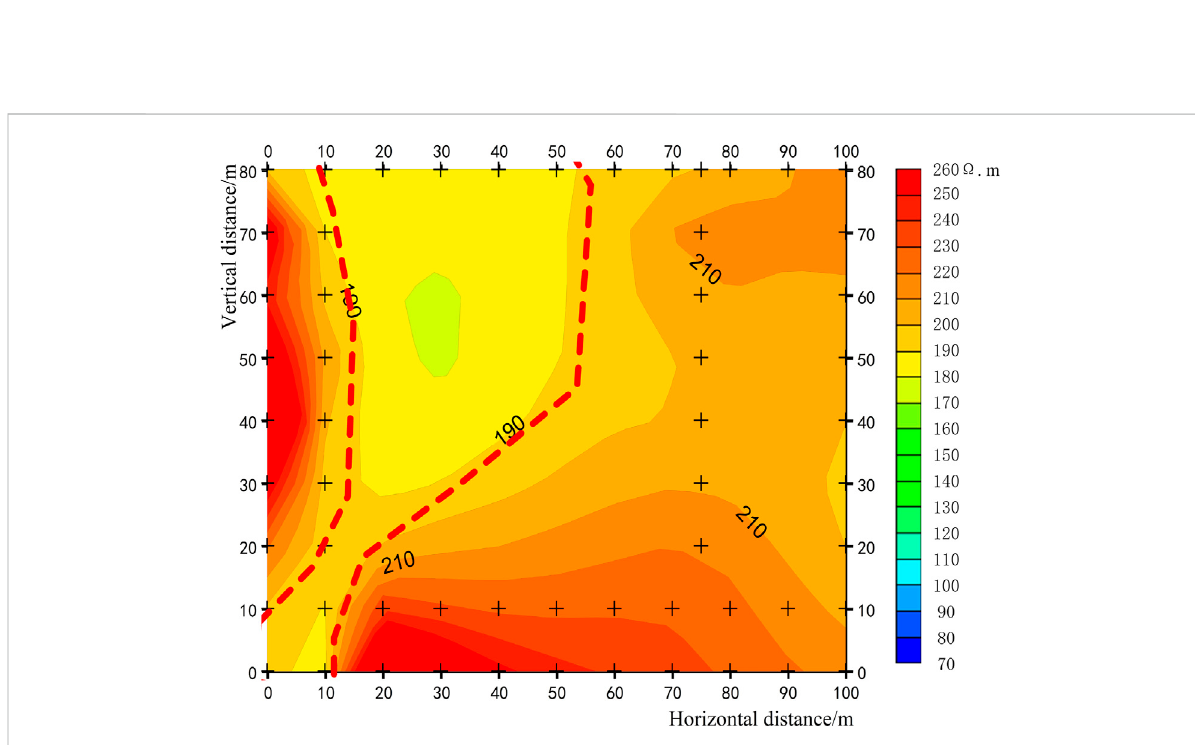
FIGURE 9 Horizontal pro fi le of apparent resistivity at a depth of -200